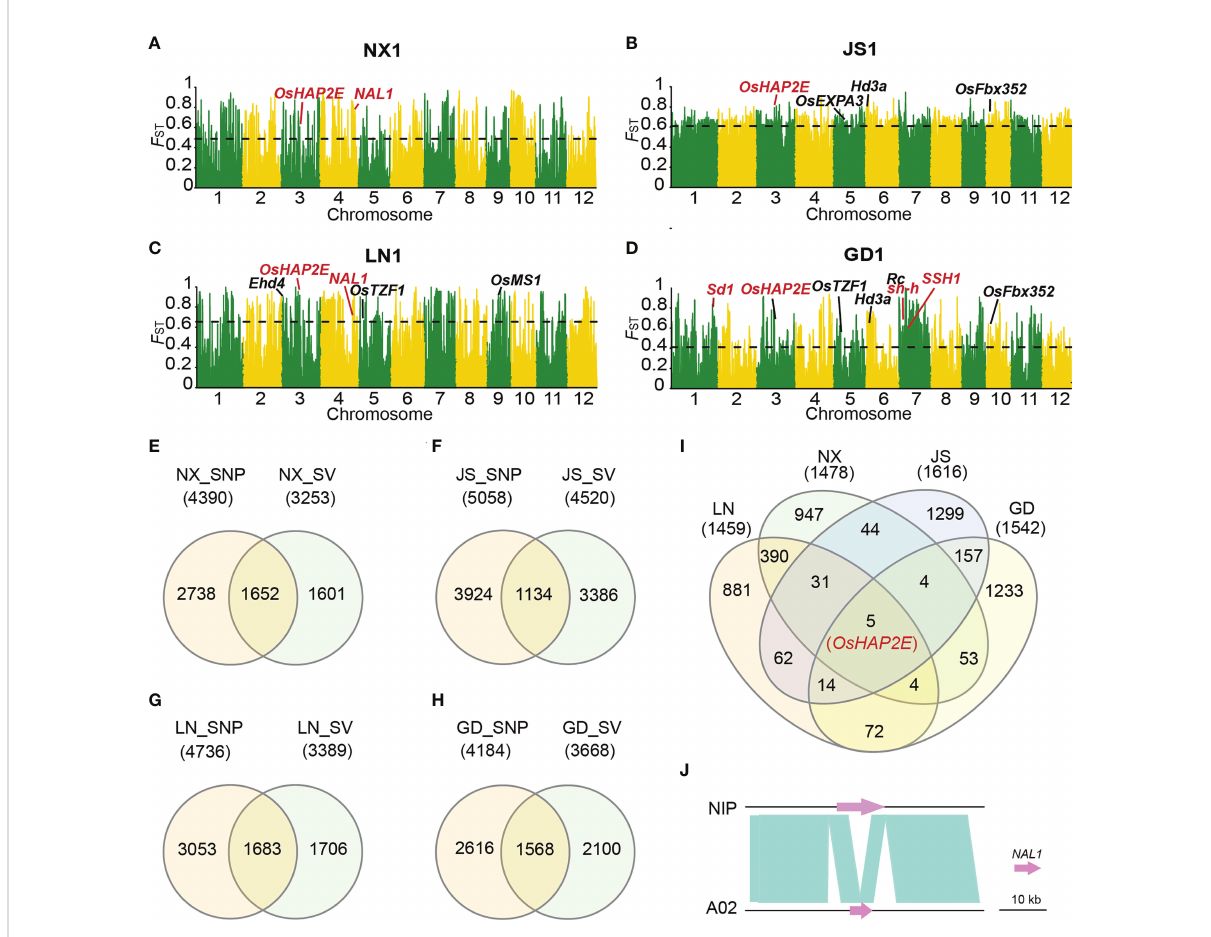
FIGURE 3 Genomic differentiation between weedy and cultivated rice from different locations. (A-D) SV- F ST between weedy rice NX1 (A) , JS1 (B) , LN1 (C) , GD1 (D) and their corresponding cultivated rice. Genes emphasized in the text were marked in red. Horizontal dashed lines correspond to the top 5% threshold. (E-H) The intersection of divergent gene regions identi fi ed through SV- F ST and SNP- F ST in NX (E) , JS (F) , LN (G) , GD (H) . (I) The intersection of divergent windows identi fi ed in four regions through SV- F ST . (J) The variation of the NAL1 gene between Nipponbare and A02. Most weedy rice lost a 5755 bp fragment in the region of the NAL1 gene compared to